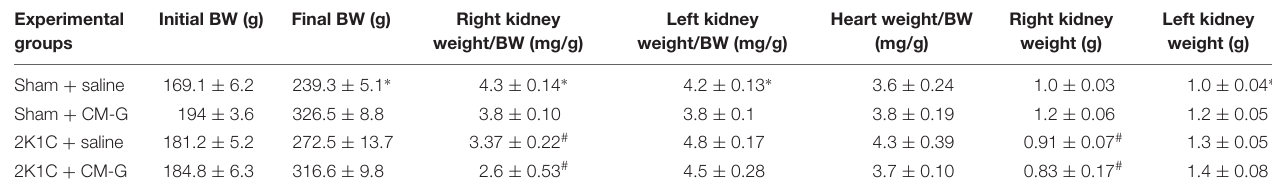
TABLE 1 | Absolute body weight (BW) and organ weight in sham rats or those treated with Carboxymethyl-glucan (CM-G). Experimental Initial BW (g) groups